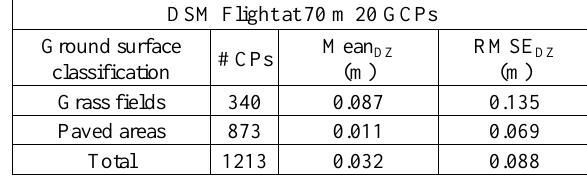
Table 8 – Differences between Kinematic GPS and DSM 70 with 20 GCPs. Figure 9 – Detail of the difference between the DSMs of the 140 m and 70 m flight (raster at 20 cm